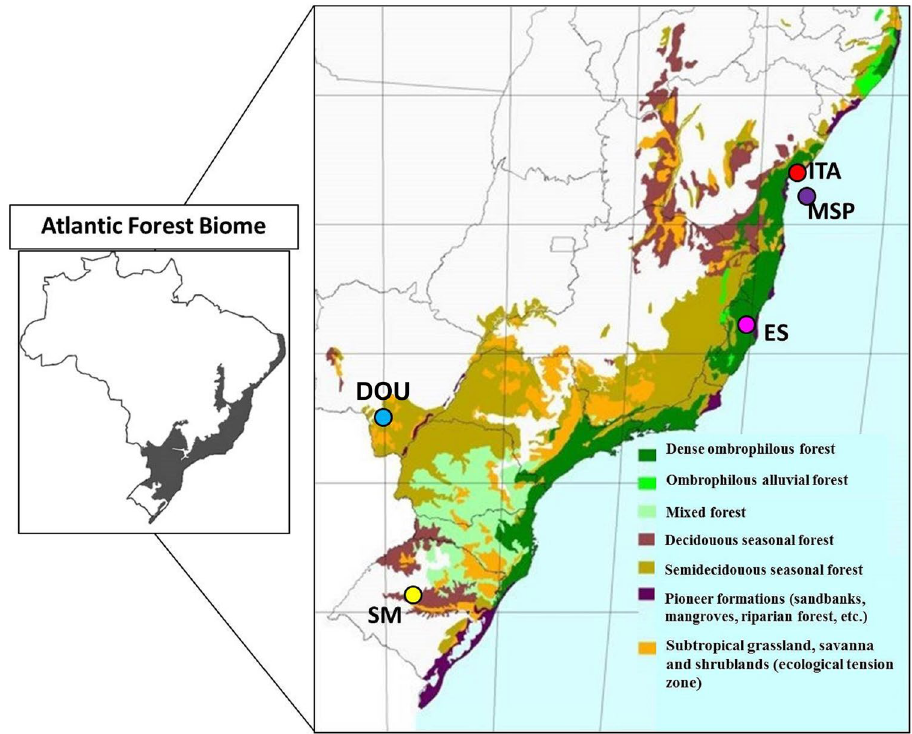
Figure 1. Distribution of S. terebinthifolia study population in different Brazilian ecosystems, all of them located in the Atlantic forest biome. Collected in ES, São Mateus-ES ; SM, Santa Maria-RS ; ITA, Vera Cruz–BA ;